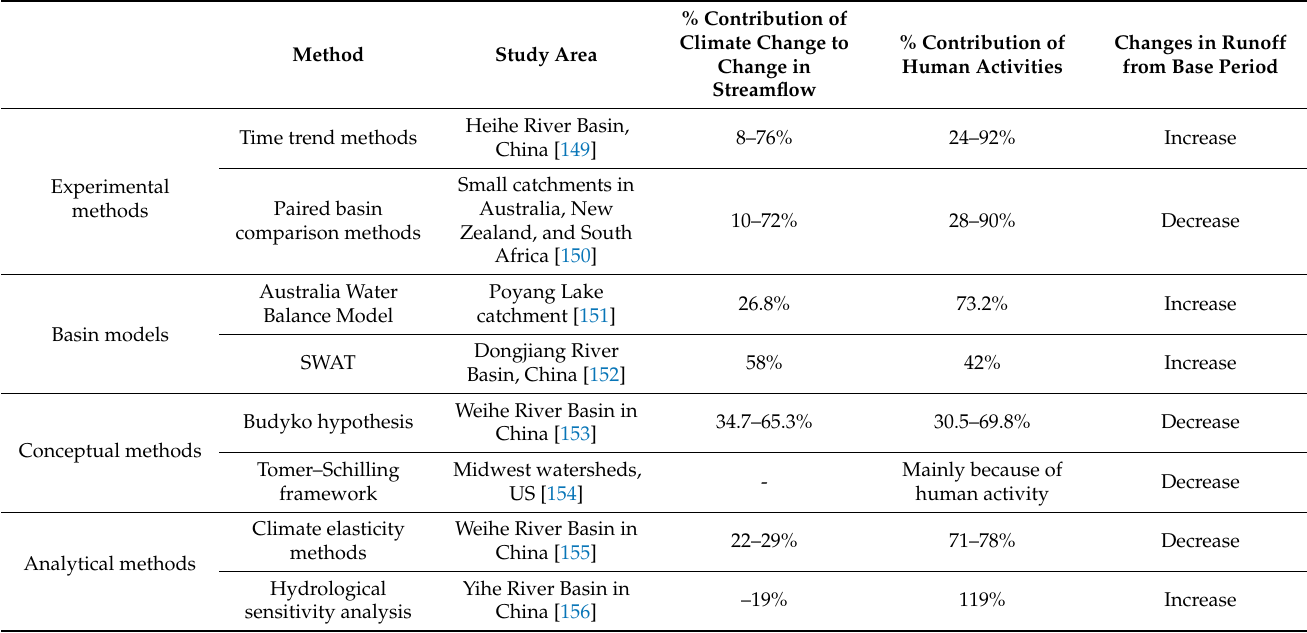
Table 1. Attribution analysis and method on runoff